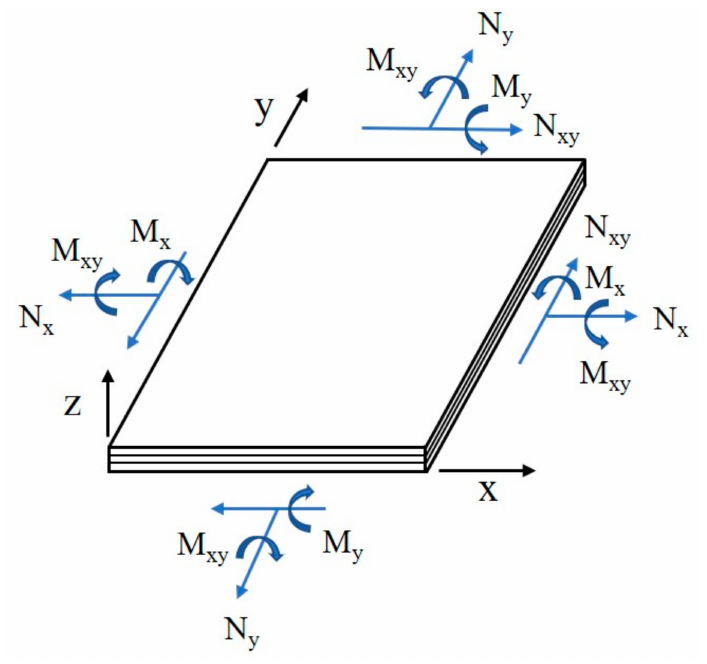
Figure 9. Positive system of laminate force and moment intensities at a